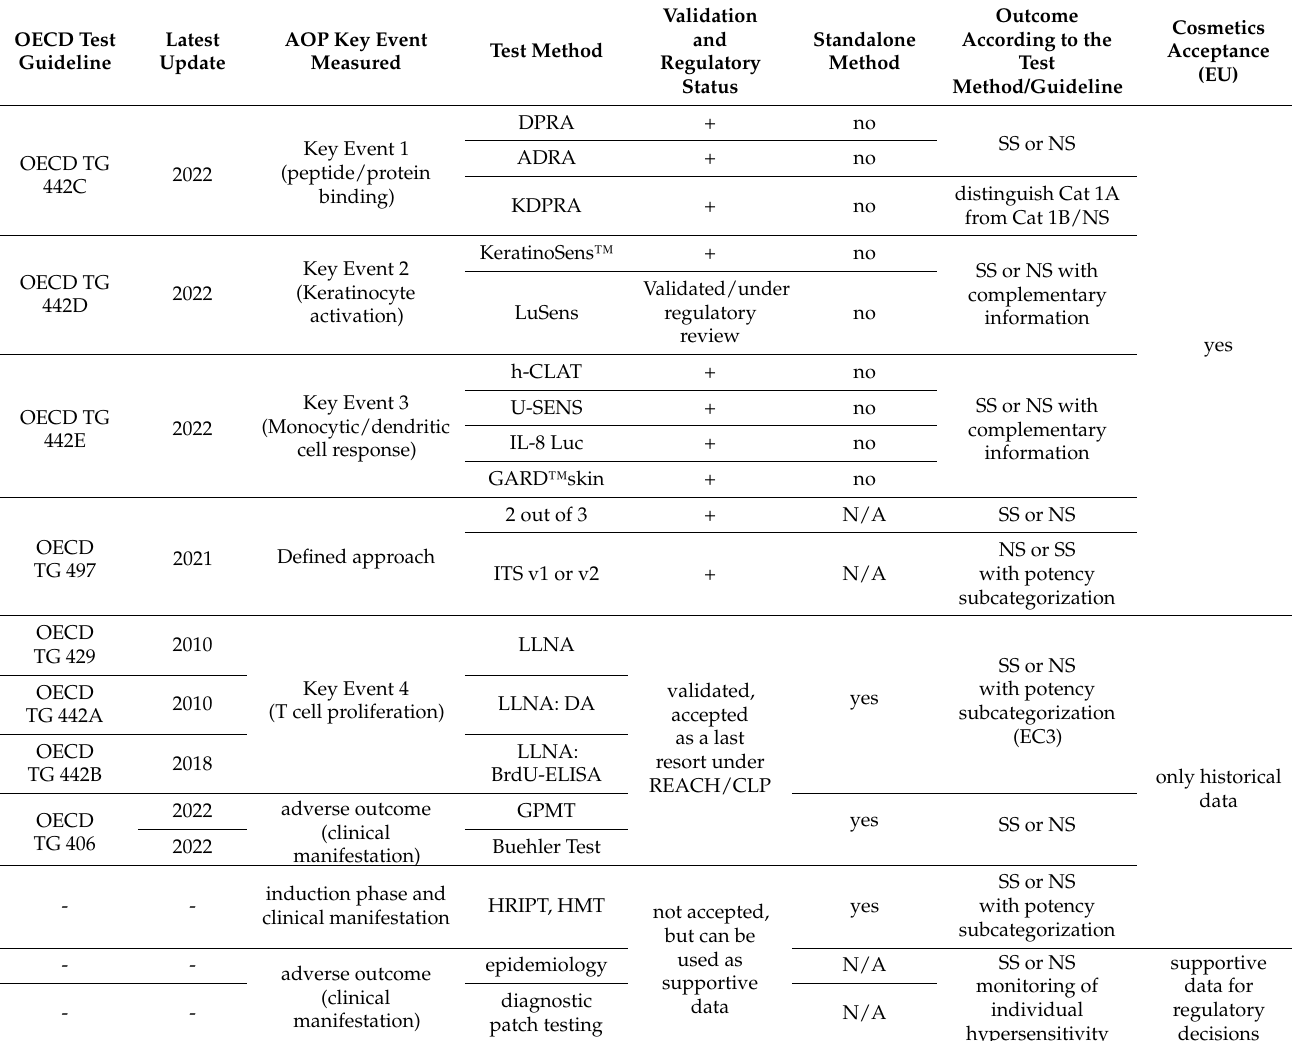
Table 1. Skin sensitization—sources of information for regulatory decision making